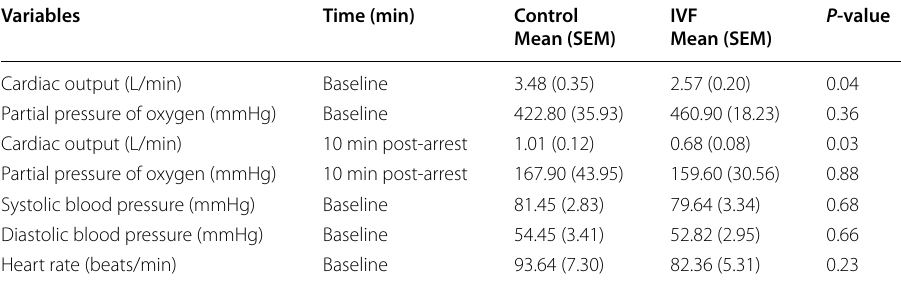
IVF intravenous fluid, SEM standard error of mean